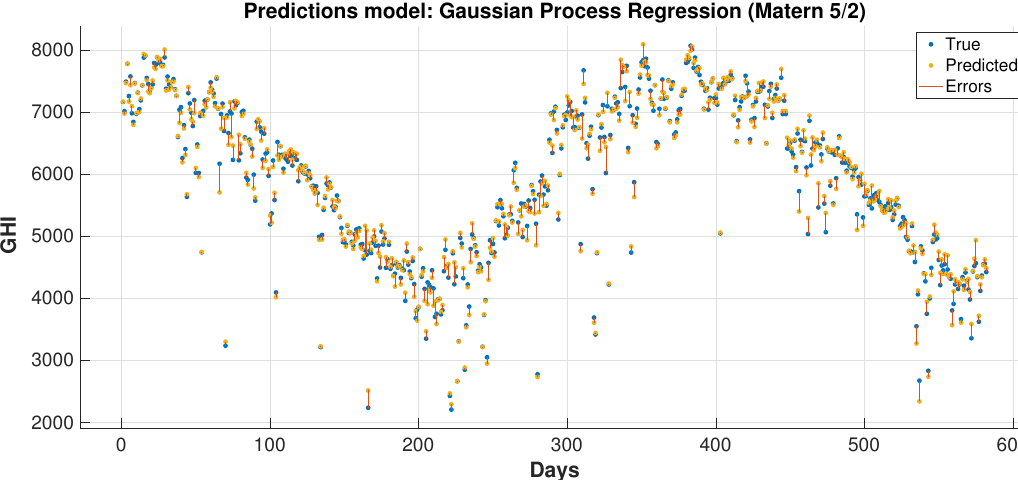
Figure 11. The predicted solar irradiance versus the real values for KAU dataset with